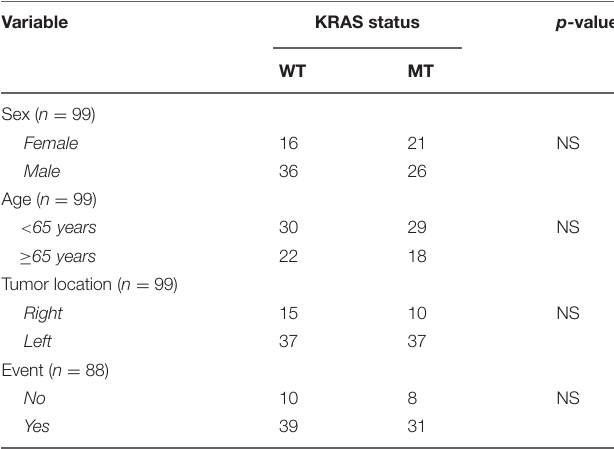
Contingency tables and X 2 test between KRAS status and patient characteris- tics. WT, wild type; MT, mutated, p-value, probability value from X 2 test; NS, not